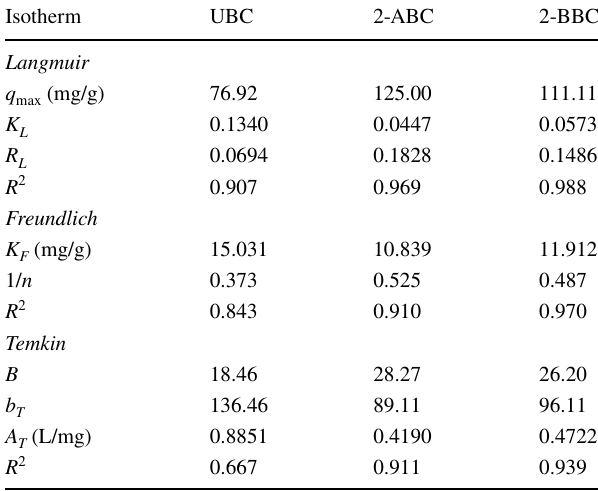
Table 1 Adsorption Isotherm